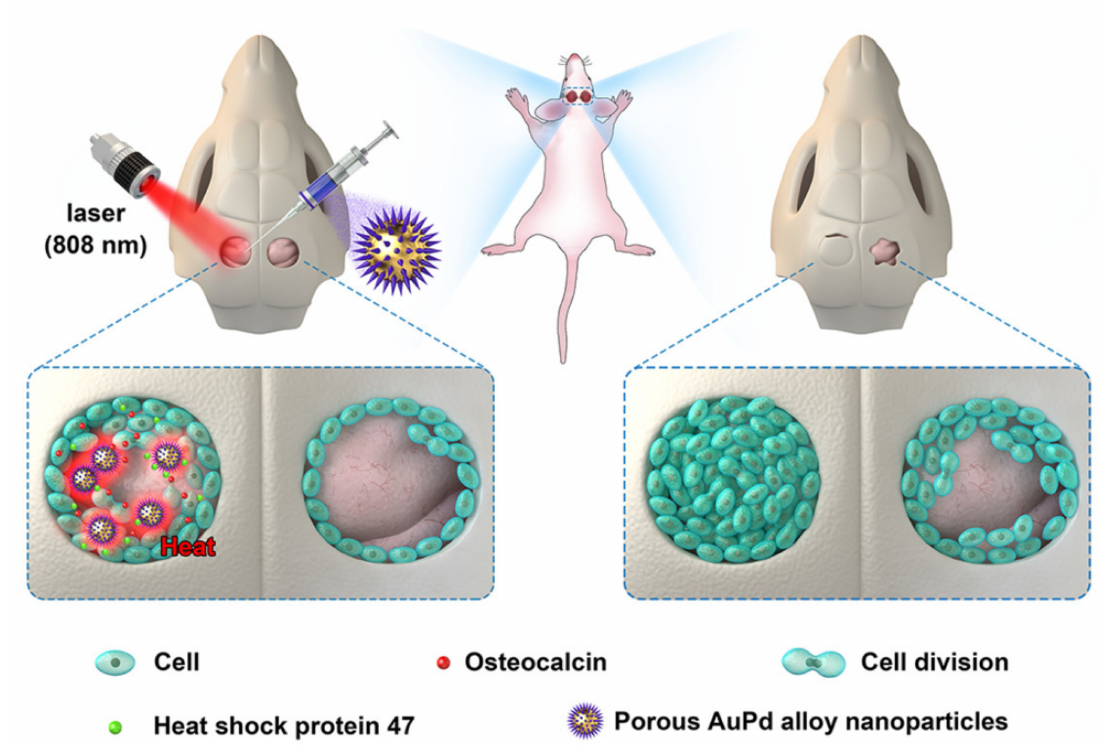
Figure 5. Schematic illustration of pAuPds for the PTT of cranial defects. Reproduced from [50], with permission of American Chemical Society 2019. Abbreviation: PTT, photothermal